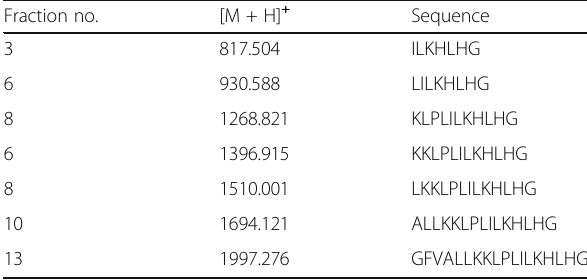
Table 4 Peptides related to xylopin Fraction no.